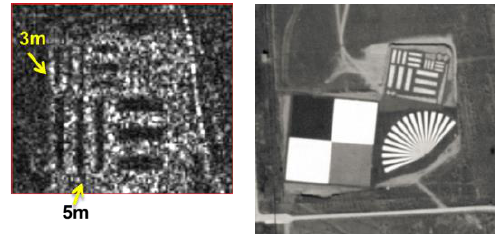
Zoomin of the bar-pattern target